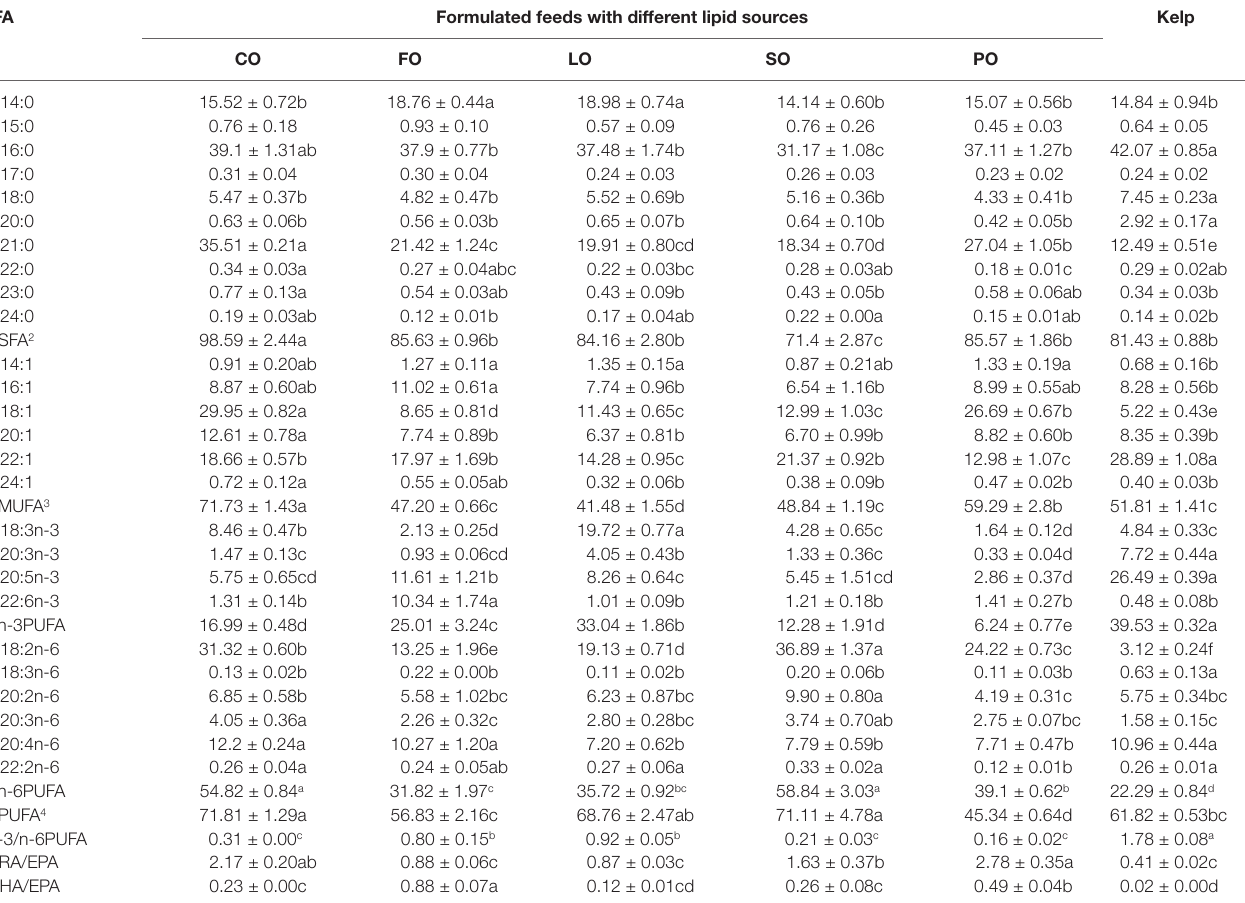
TABLE 8 | Effects of different lipid sources on the fatty acid composition (g/kg dry matter) in the ovary of adult sea urchin ( Strongylocentrotus intermedius ) (mean ± SEM, n=3) 1 . FA Formulated feeds with different lipid sources Kelp CO FO LO SO